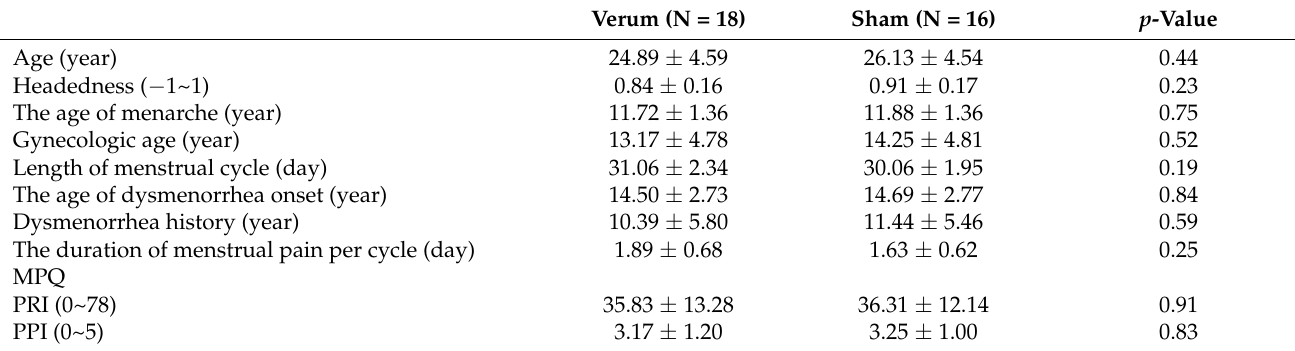
Table 1. Clinical and demographic data of women with primary dysmenorrhea.